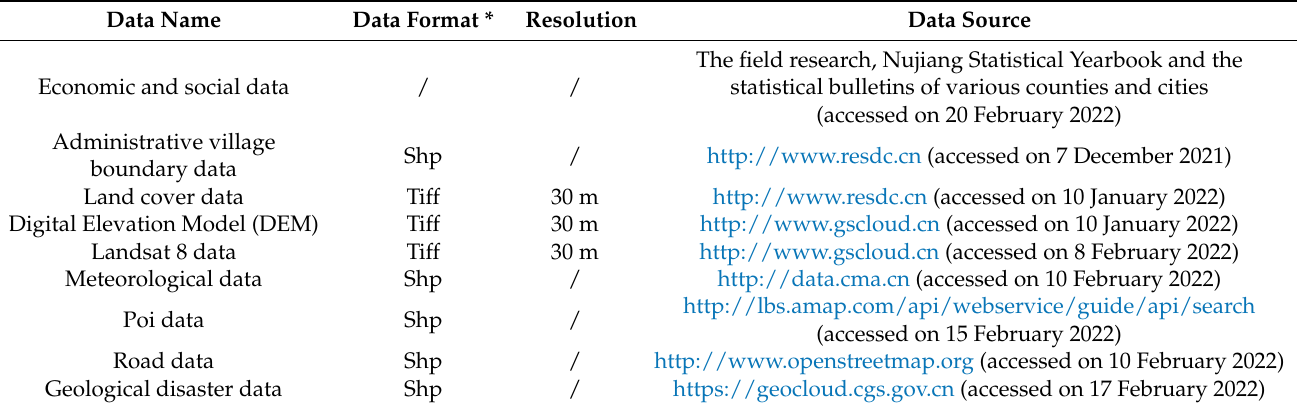
Table 1. Data name, format, and